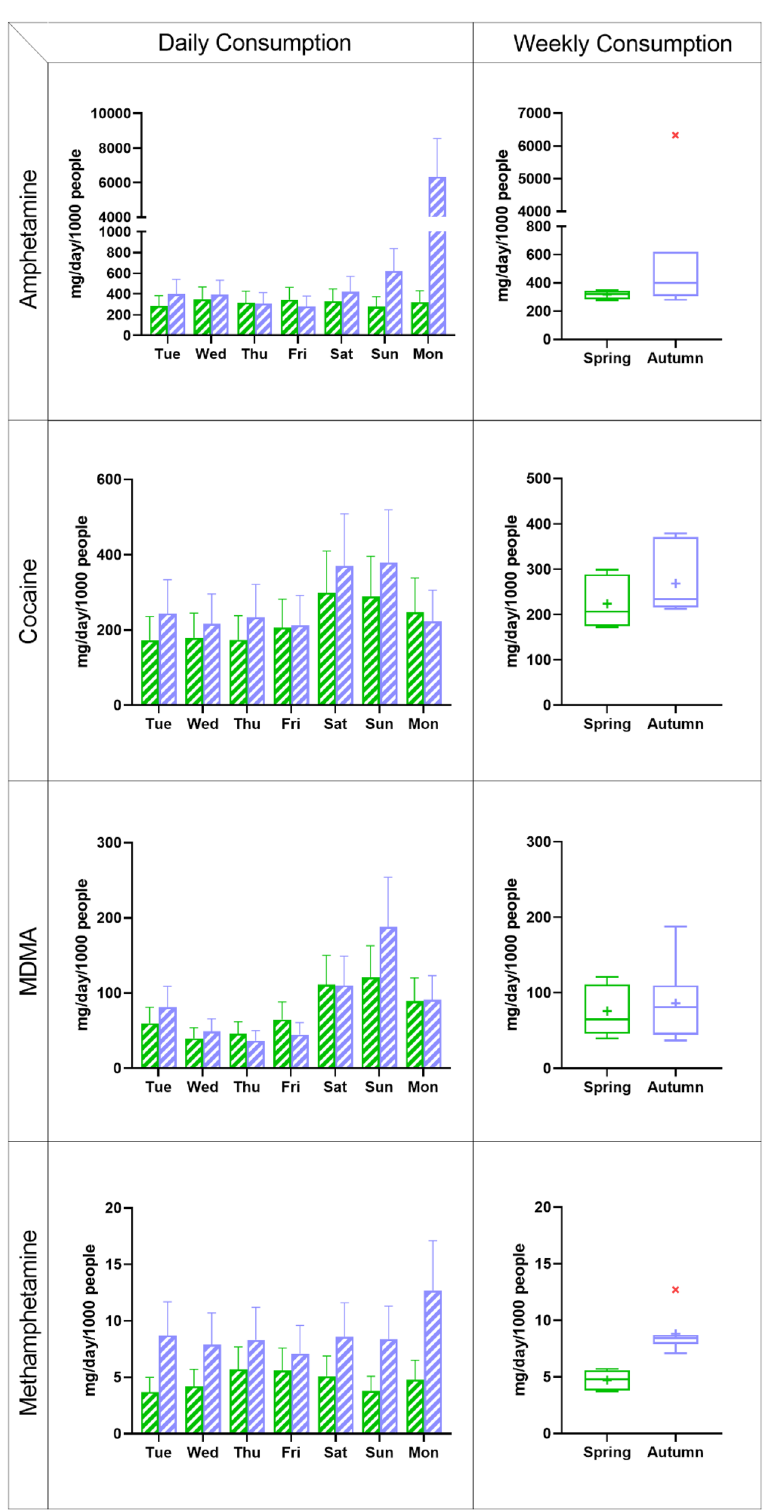
Figure 1. Day-to-day (bar chart) and weekly (Tukey box-and-whisker plot) drug consumption in Uppsala in two studied periods (green: campaign 1 in spring; purple: campaign 2 in autumn). Error bars taken in account the uncertainty of sampling, chemical analysis, flow measurement, excretion fraction and population as previously described 21,36,46 . In the box plot (see “Methods” for details), a red cross indicates an outlier and + represents an average